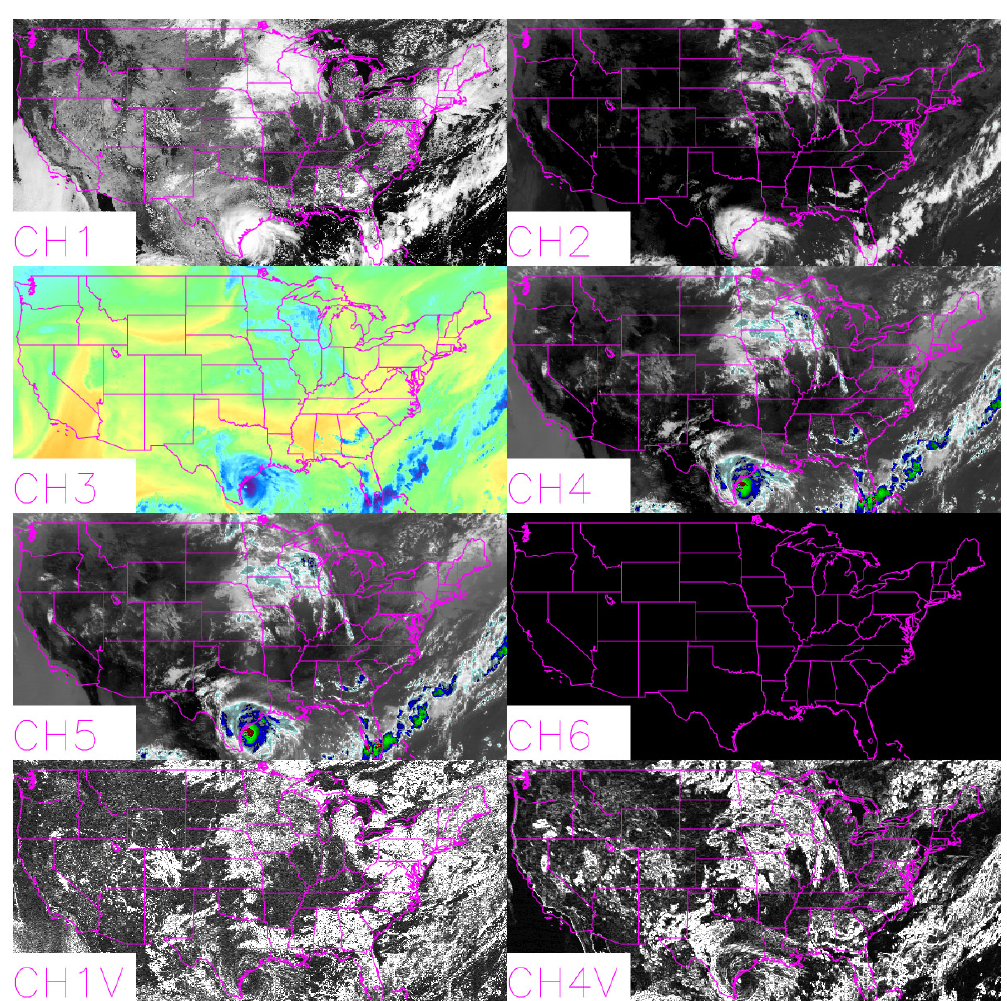
Figure 2. Sample images produced from GridSat-CONUS for 19 August 1999 at 17:45UTC showing all eight channels. Since this is GOES 8, there is no channel 6 data; central wavelengths are provided in Sect. 4.1. Visible data are enhanced to show detail across the dynamic